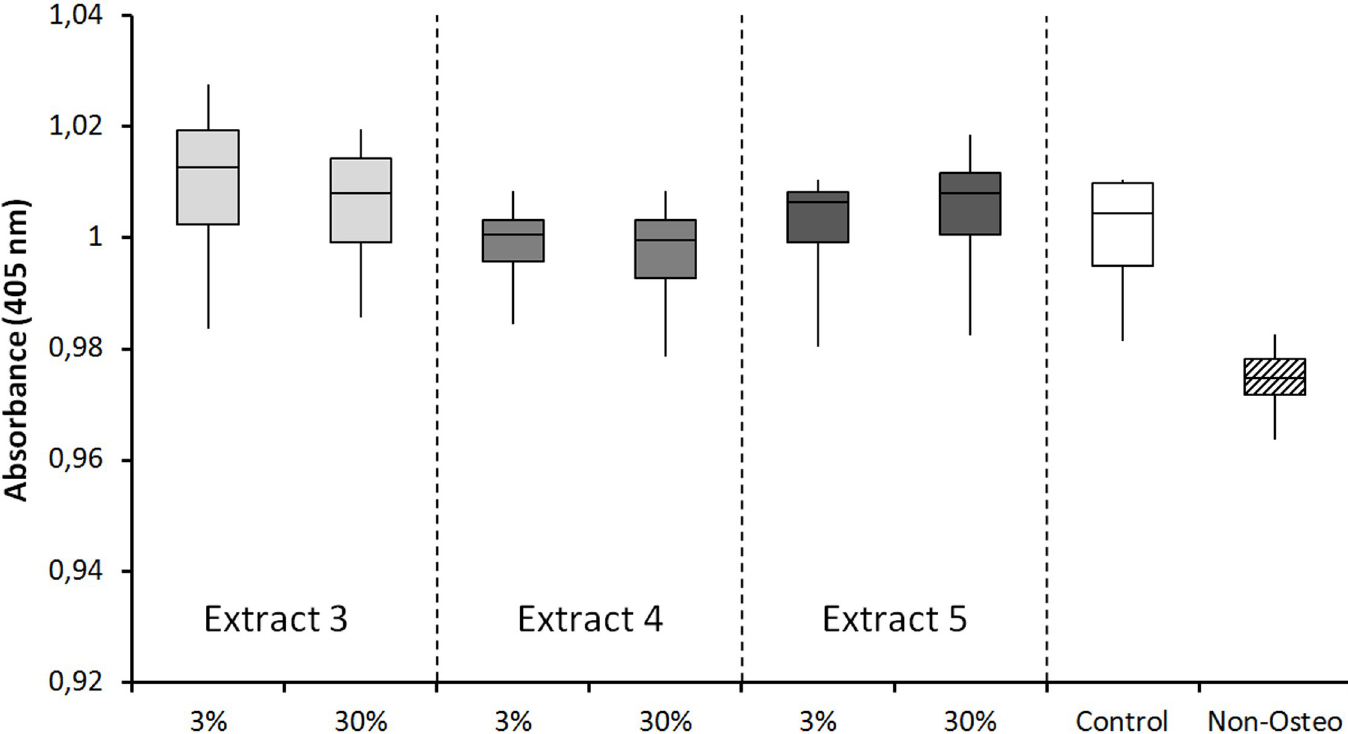
Fig 3. Alizarin red assay quantification of human MCSs osteogenesis. Effects of extracts of IVD tissues from three different patients, applied at two, indicated concentration, on human MSCs in osteogenic medium, using an Alizarin red S assay. No significant differences were obtained compared to the control MSCs in osteogenic medium without extract. MSCs in non-osteogenic medium (non-osteo) produced less mineral.